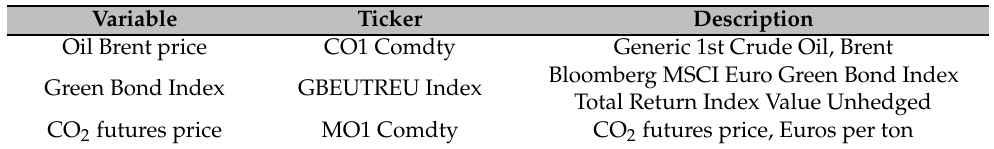
Table 1. List of variables. Variable Ticker Description Oil Brent price CO1 Comdty Generic 1st Crude Oil, Brent Green Bond